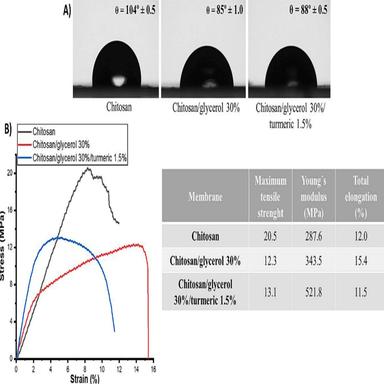
(A) Contact angle images between the membranes and water (t = 1 s), the θ value is shown in the inset. (B) Mechanical tensile strength tests.